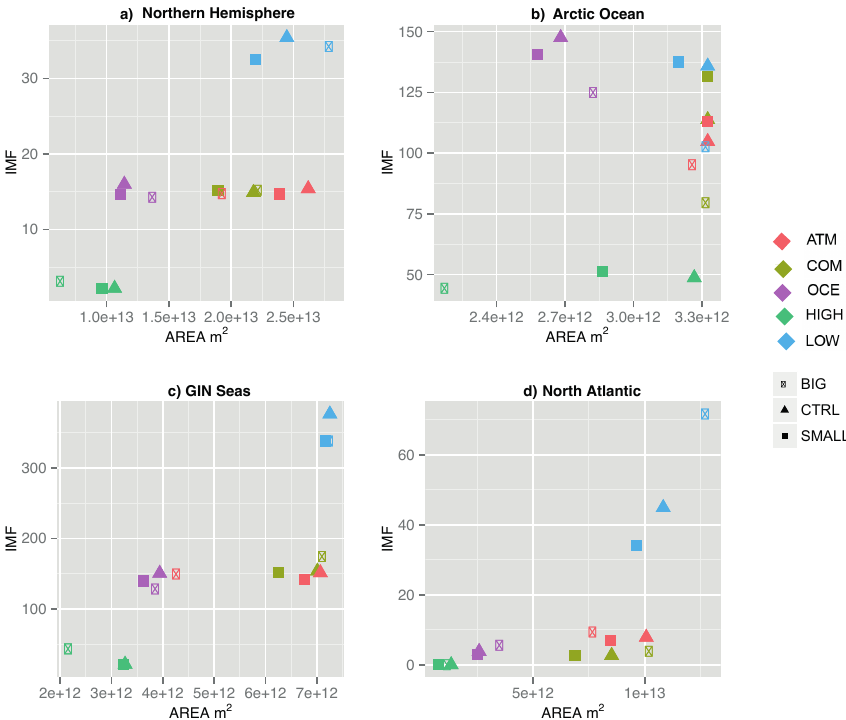
Figure 2. Area (m 2 ) vs. area weighted iceberg melt flux (m 3 s − 1 ); the area is computed by taking into account all the grid cells that have at least 10 icebergs passing through per year (be aware that the area is 10 13 m 2 in a , 10 12 m 2 otherwise); (a) Northern Hemisphere: mean computed over 0–90 ◦ N and 180 ◦ W–180 ◦ E, values of IMF: 0–40m 3 s − 1 (area weighted IMF); (b) Arctic Ocean: 80–90 ◦ N and 180 ◦ W–180 ◦ E, values of IMF: 60–140m 3 s − 1 ; (c) Greenland–Iceland–Norwegian (GIN) seas: 50–85 ◦ N and 45 ◦ W–15 ◦ E, values of